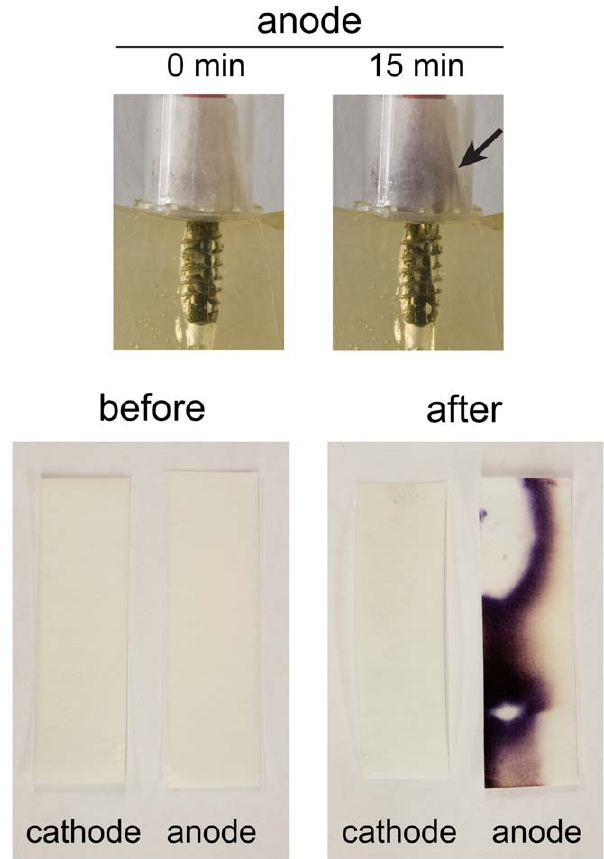
Figure 5. Production of oxidizing species in the vicinity of the implants. Potassium iodide-starch paper before and after the treatment of implants in simulated soft tissue showed a dark blue coloration for the anode after electrolysis. This is in agreement with electrochemical oxidation taking place exclusively at the anode.